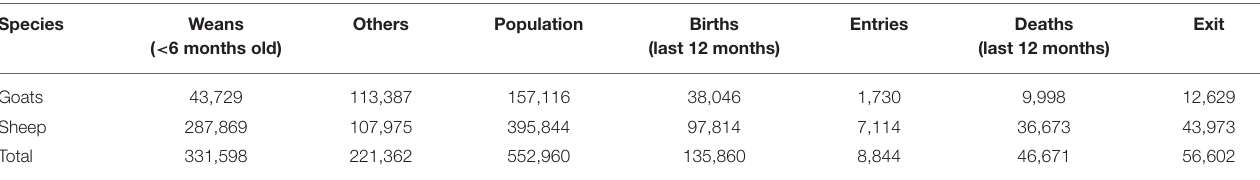
TABLE 1 | Data from national demographic survey conducted in 2015. Species